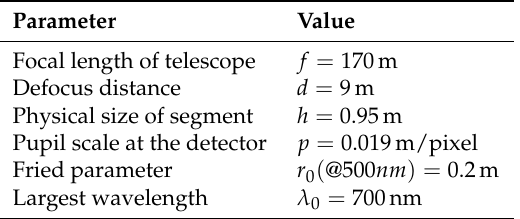
Table 1. Simulation